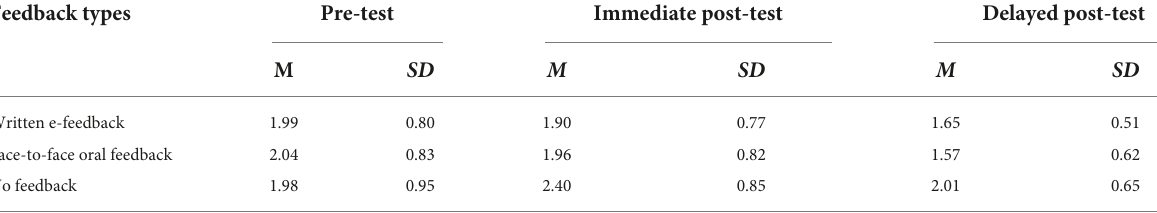
TABLE 3 Descriptive statistics of article errors at pre and post-tests.